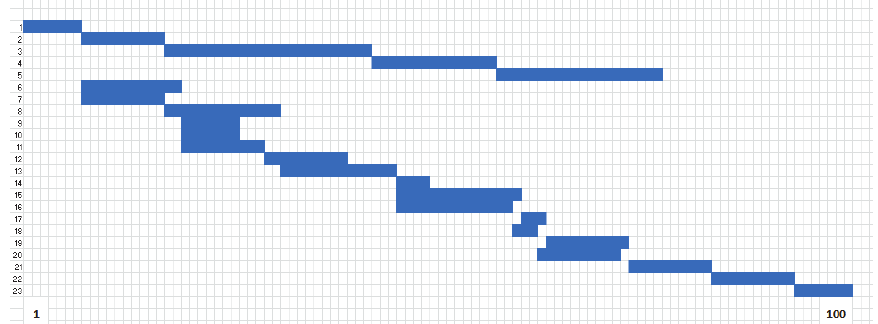
Fig. 14. Gantt chart of the validating experiment with relaxed resource